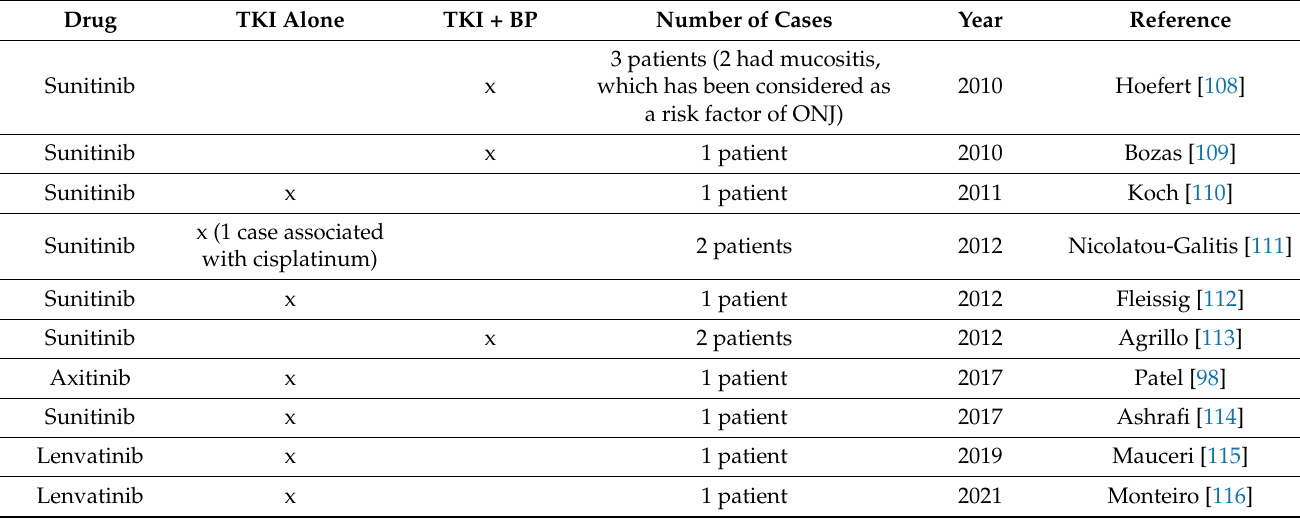
Table 2. Case reports of ONJ in RCC patients treated with TKI or TKI +